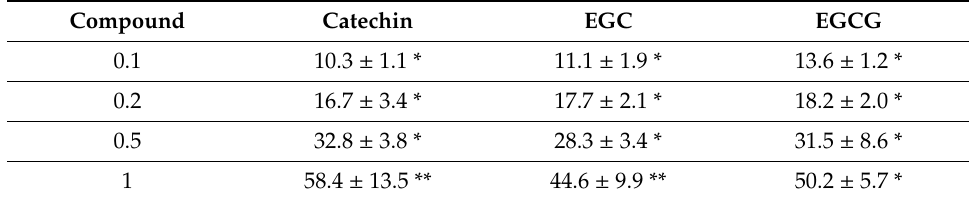
Table 5. Protection by monomeric flavanols against hypochlorite-induced oxidation of erythrocyte Table 6. Protection by monomeric flavanols against hypochlorite-induced erythrocyte membrane membrane protein thiol groups. * p < 0.05, ** p < 0.01 (with respect to control). lipid peroxidation. * p < 0.05, ** p < 0.01 (with respect to control).